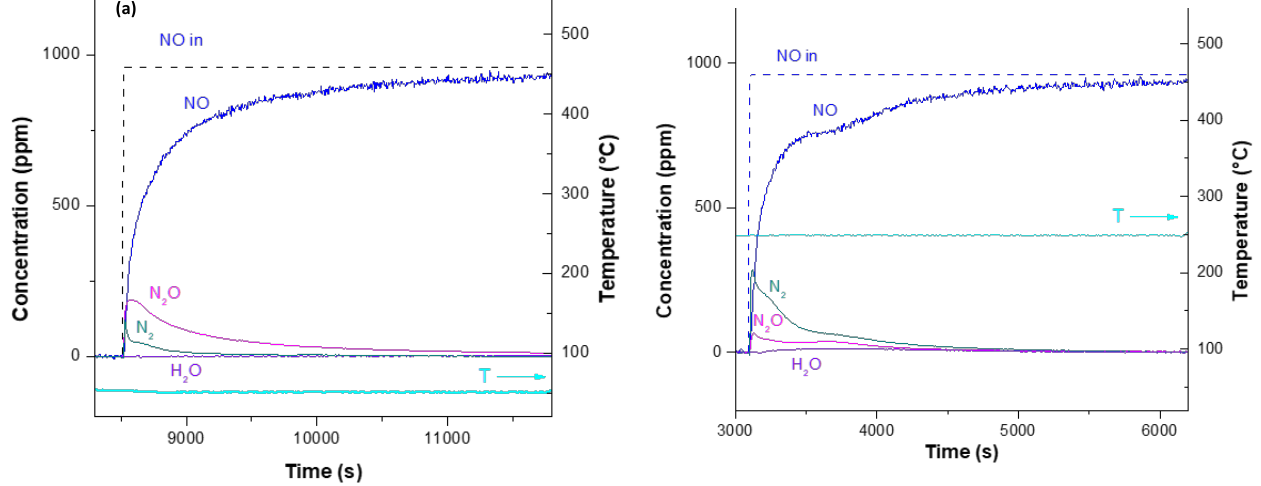
Figure 4. NO reduction experiment at 50 °C ( a ) and 250 °C ( b ) for pre-reduced Ba6/Cu2CZ.